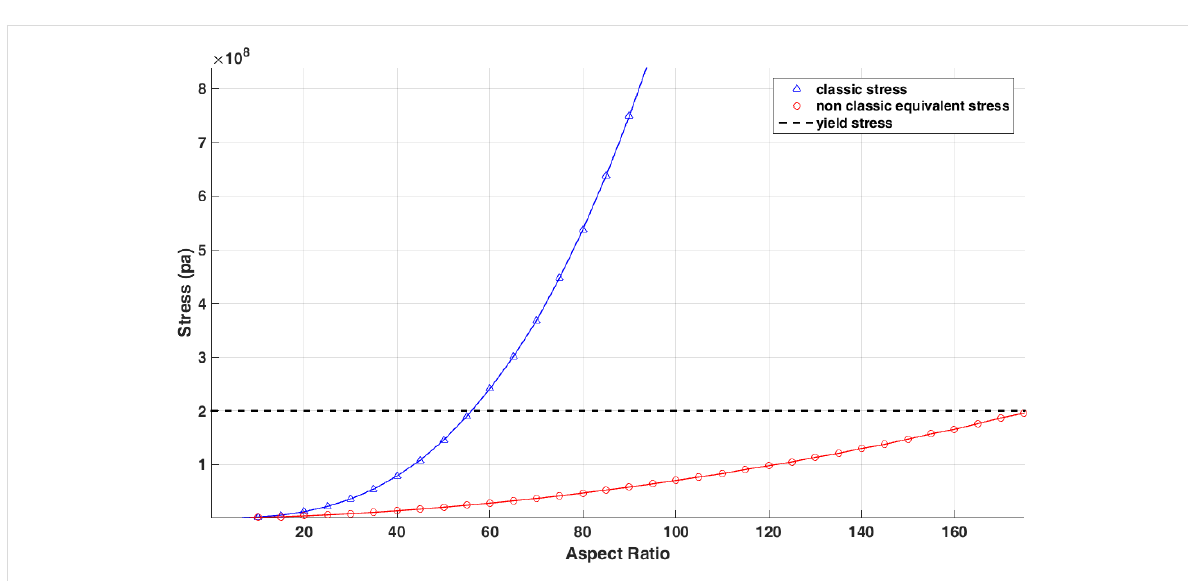
Figure 16: Comparison of the classical stresses and nonclassical equivalent stresses with respect to changes in aspect ratio.